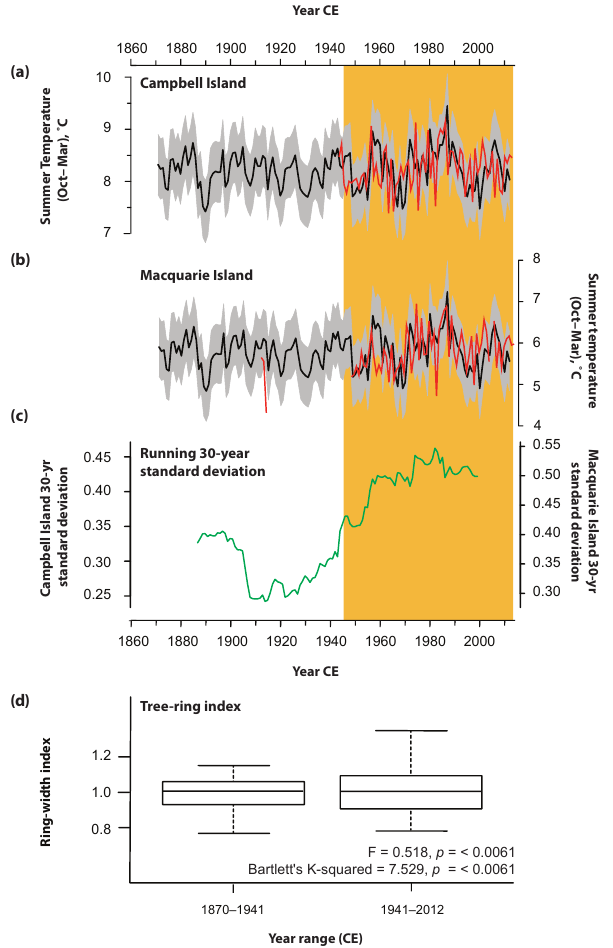
Figure 3. 140-year temperature variability in the subantarctic Pa- cific. Campbell Island (a) and Macquarie Island (b) observed (red lines) and Dracophyllum reconstructed (black) growing season tem- peratures (October–March) with 90% quantile limits (grey enve- lope) compared against running 30-year mean standard deviation of the reconstructed temperature series (c) . (d) Box-and-whisker plots of the ring width indices with summary statistics indicating a sig- nificant difference in variance between the periods CE1870–1941 and 1941–2012. Orange column defines significant post-1940s tem- perature variability in the record.